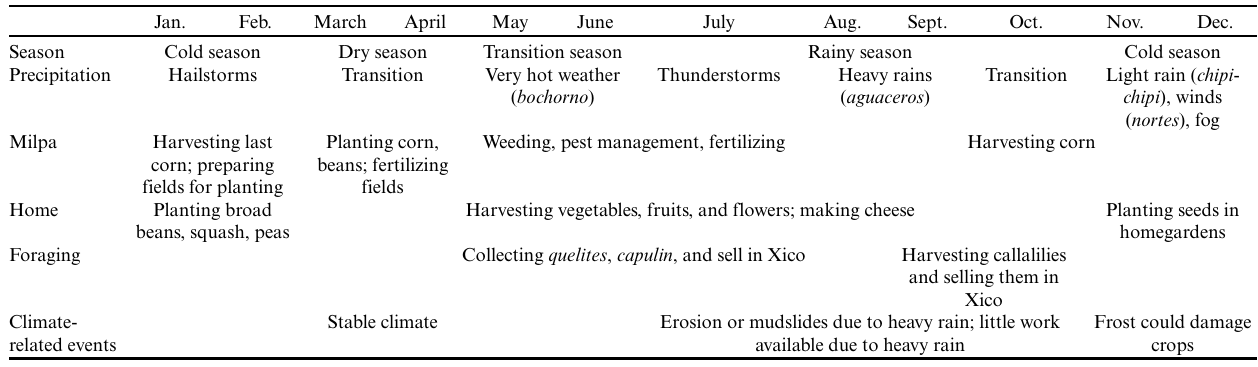
Table 2 . Agricultural calendar for Coatitilán, divided by weather events and tasks in different livelihood domains.